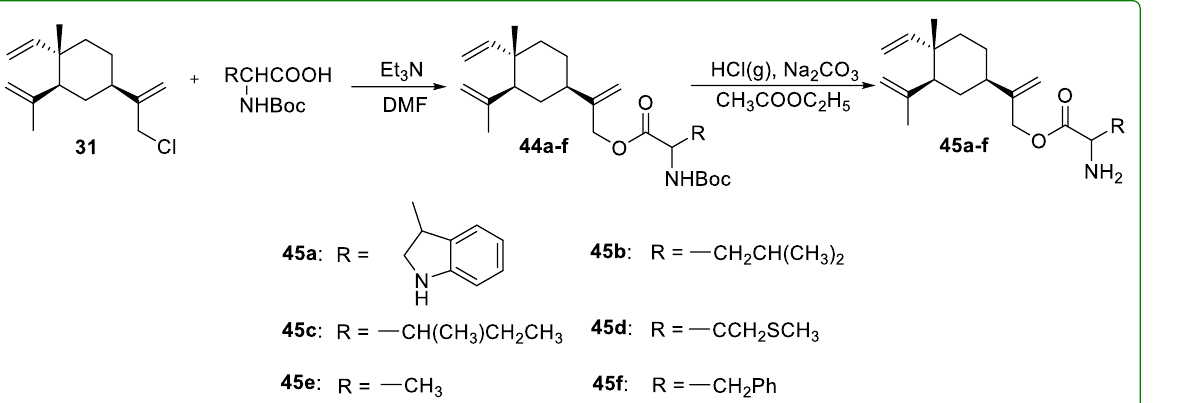
Figure 15. Chemical structures of β -elemene ester derivatives 46a – y . Chen et al. [114] also designed and synthesized several β -elemene dimer ester deriv- atives and investigated their antioxidant activity on HUVECs. Furthermore, 13-monosub- stituted dimers 47a and 47b (Figure 16) demonstrated the most effective antioxidant ac- tivity associated with the production inhibition of ROS, which were better than the posi- tive control vitamin E. Intriguingly, the antioxidant activity of 14-monosubstituted dimers 48a and 48b (Figure 16) was weaker than 13-monosubstituted dimers 47a and 47b . More- over, compound 47c (Figure 16) showed no obvious cytotoxicity to HUVECs and dis- played more active antioxidant activity than vitamin E and compound 47a . Further stud- ies indicated that compound 47c could increase the expression of superoxide dismutase and nitric oxide release in cells, and significantly reduce intracellular malondialdehyde and lactate dehydrogenase [105].